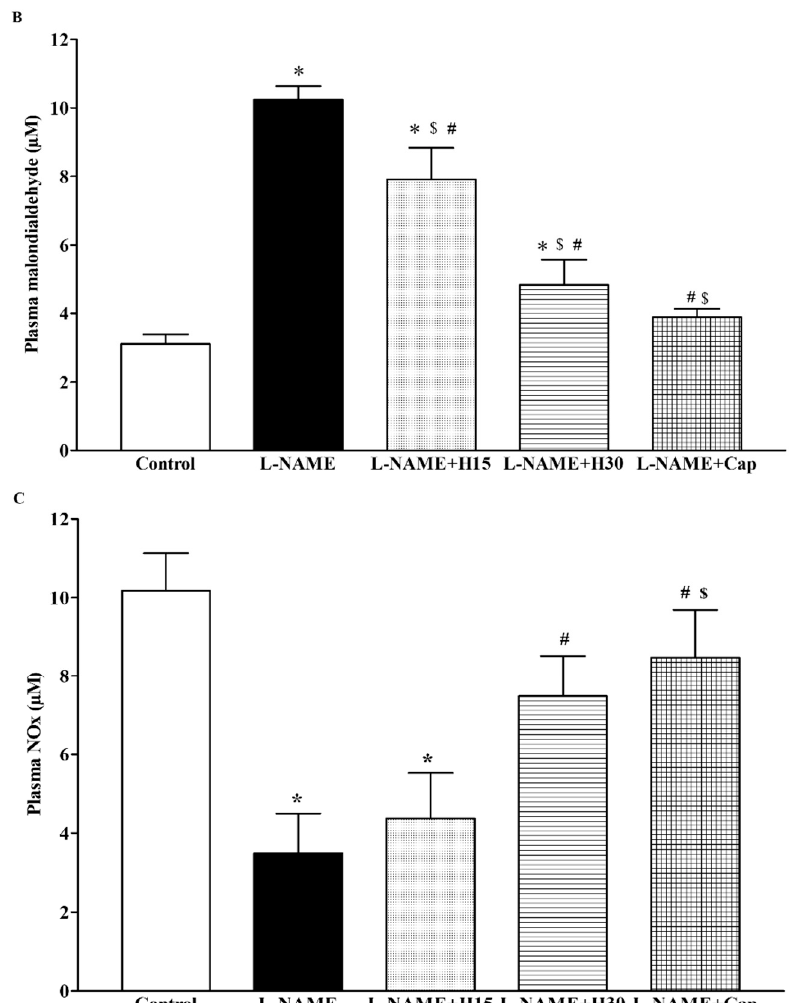
Figure 4. Effects of hesperidin and captopril supplementation on vascular O 2• − production, ( A ) plasma